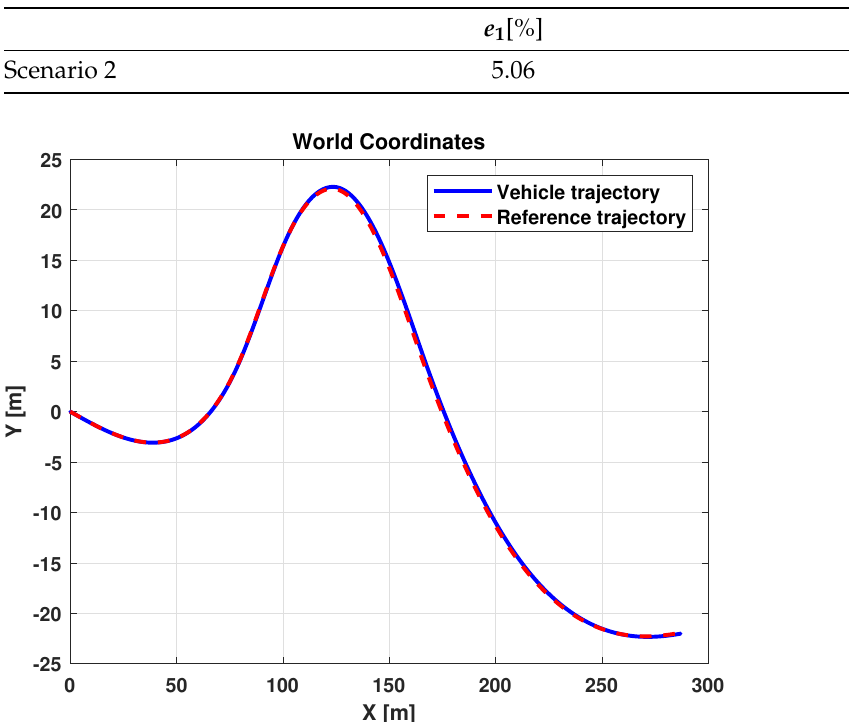
Figure 18. Simulation scenario 2: vehicle and reference trajectories.